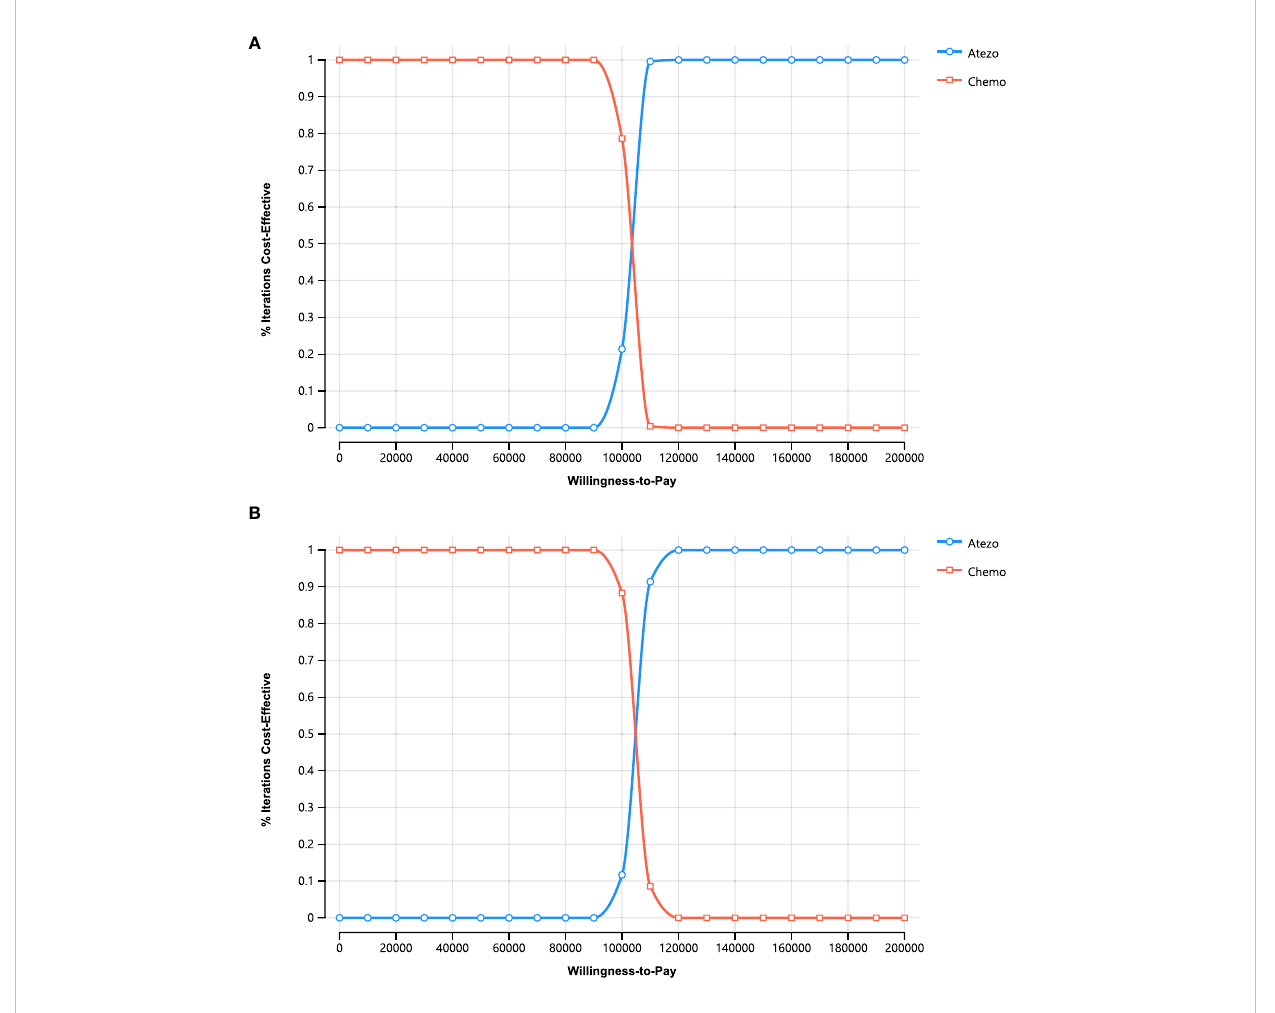
FIGURE 4 Cost-effectiveness acceptability curves for stochastic analysis. (A) PartSA model. (B) Markov